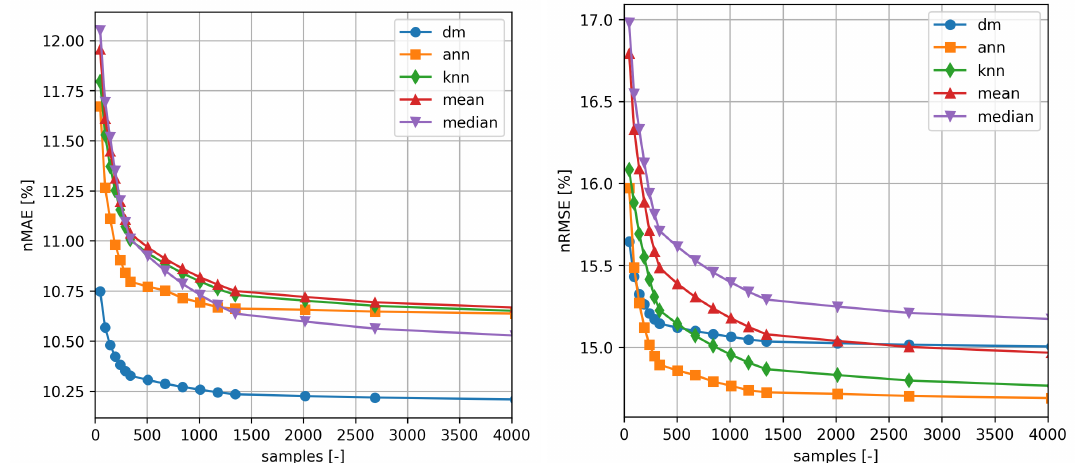
Figure 6. Normalized MAE and RMSE as a function of the training set samples size, for turbine